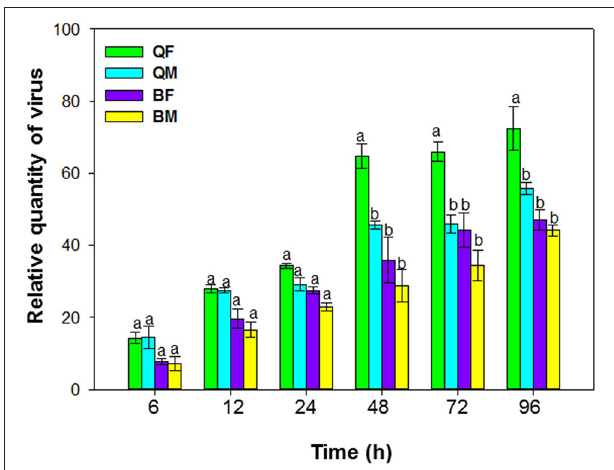
FIGURE 1 | Acquisition of tomato chlorosis virus by B. tabaci MEAM1 and MED. QF, MED females; QM, MED males; BF, MEAM1 females; BM, MEAM1 males. Values are means ± SE. For each time, means with different letters are significantly different ( P < 0.05; N =